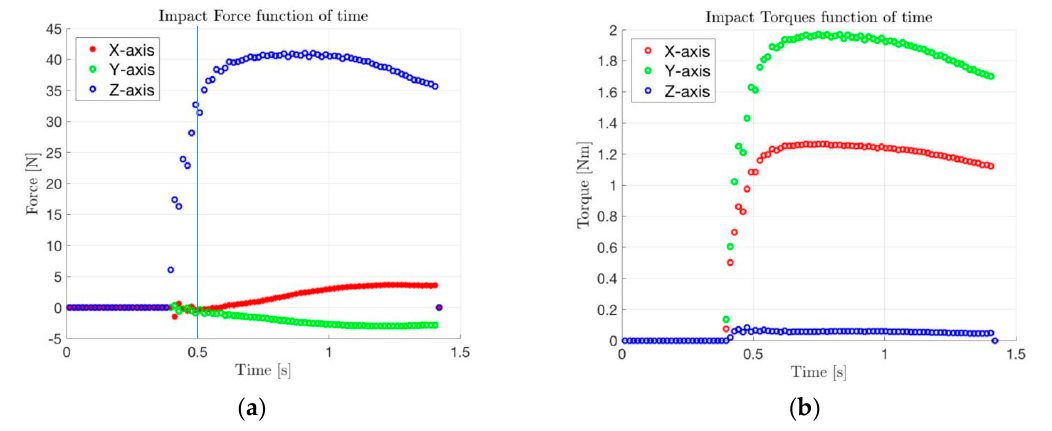
Figure 9. Nominal Case ( v = 0.030 m/s): ( a ) forces at impact and ( b ) torques at impact.